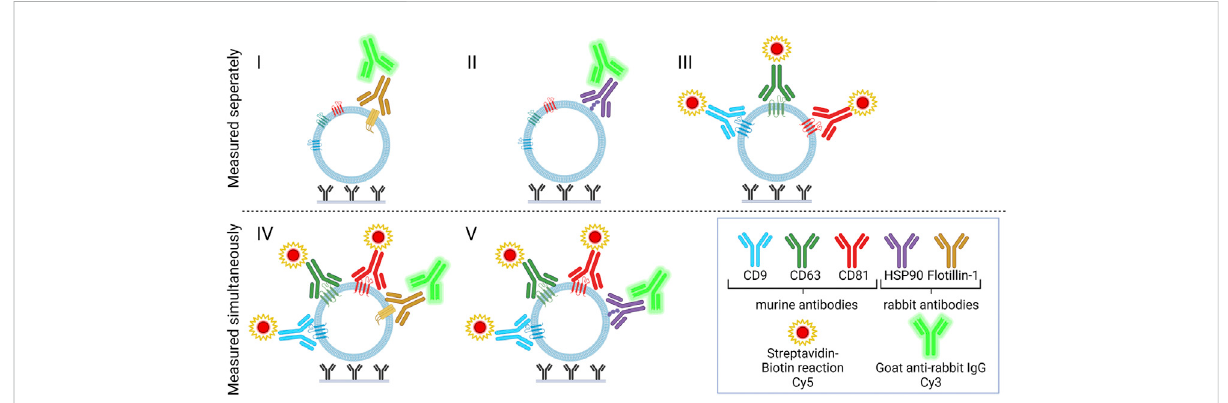
FIGURE 2 Immune-mediated EV capture and detection for dual targeting of surface or surface-associated proteins. Capture antibodies(murine), positive control(biotinylatedIgGorrabbitanti- Mycoplasmapneumoniae IgG),andnegativecontrol(PBS)wereprintedontoglassslides.Slideswereaddedto plasma samples and incubated overnight. For the detection of EVs, detection molecules (biotinylated murine anti-CD9, -CD63, and -CD81 and/or rabbit anti-HSP90 and - fl otillin-1) were added, and two separate fl uorescent signals were obtained with Cy5-labeled streptavidin and/or Cy3- labeled goat anti-rabbit IgG. Compositions I, II, and III were measured separately, whereas IV and V were measured